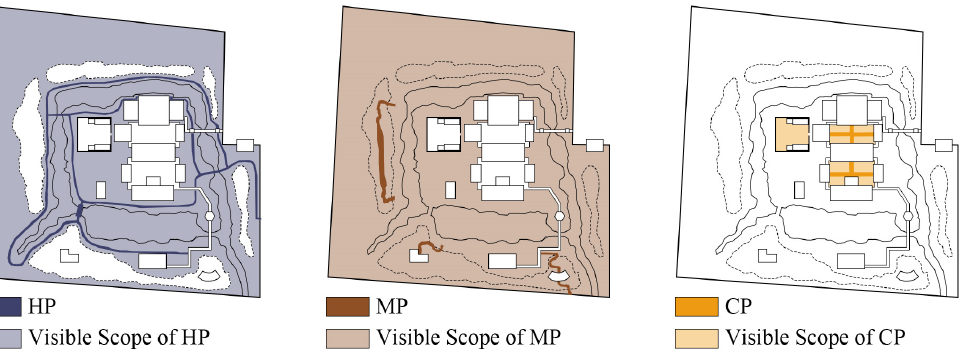
Figure 5. Schematic diagram of the scope of view (again, the example is the Chunwangfu Garden: Left: view of HP; Middle: view of MP; Right: view of